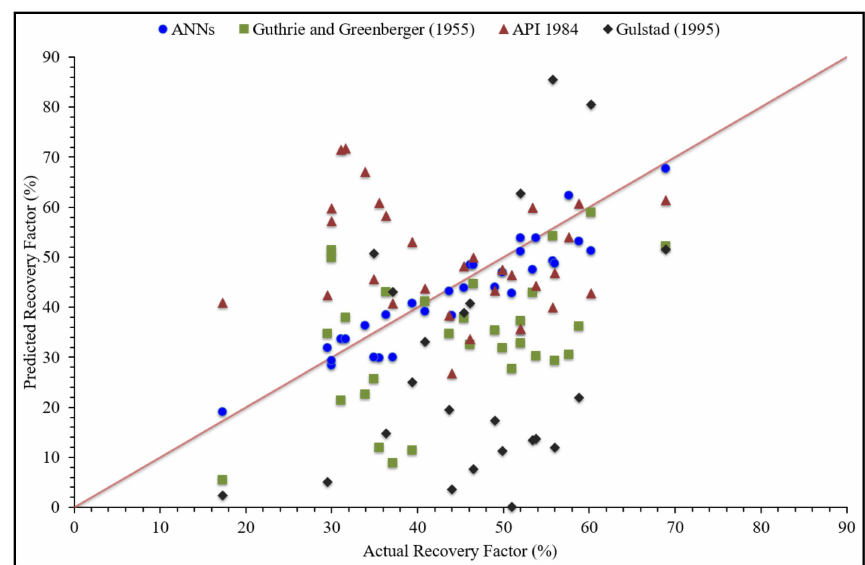
Figure 6. Cross-plot of the predicted and actual RF estimated by ANN-based, Guthrie and Greenberger, API, and Gulstad correlations.